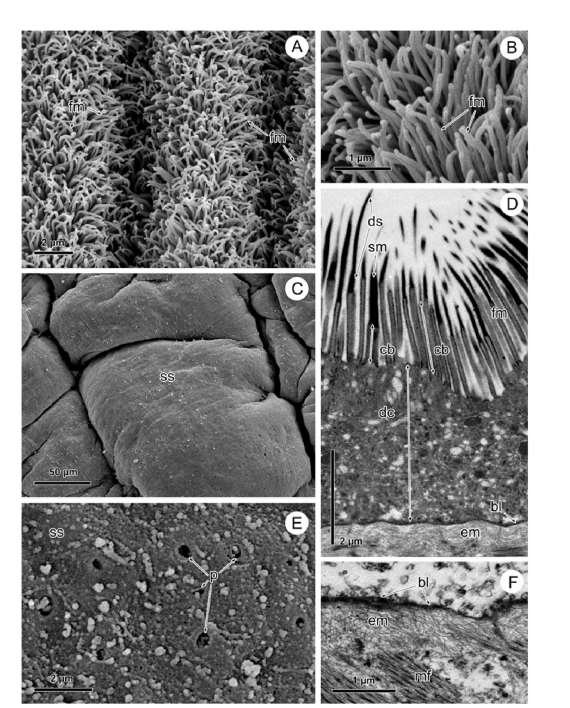
FIGURE 1 Histological dissections of whitefish intestine infected by Proteocephalus sp. (A,B) – sections were stained by Alcian Blue at pH 2.5; (C–F) by Harris’ Hematoxylin and Eosin. cs, cestode; if, intestinal folds; ic, intestinal